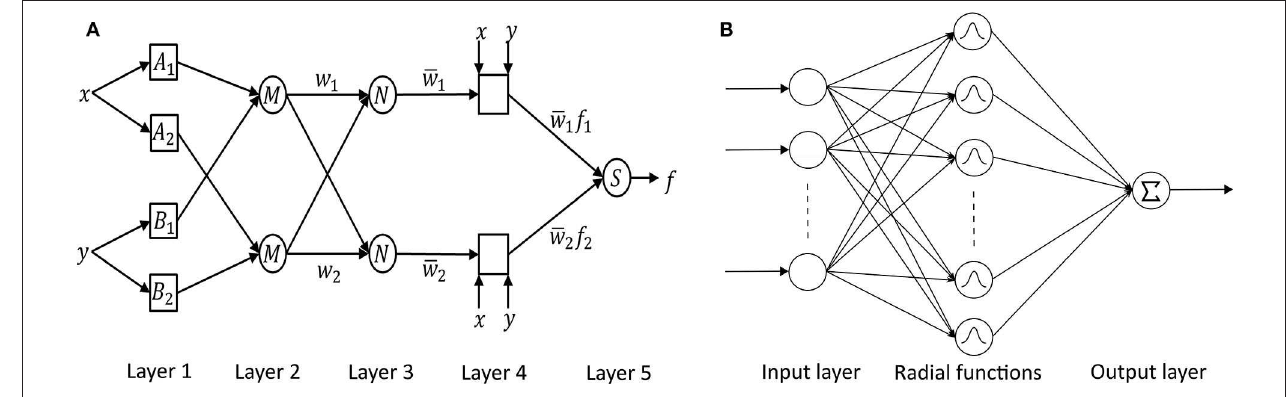
FIGURE 6 | (A) ANFIS (118) and (B) RBFNN (119)